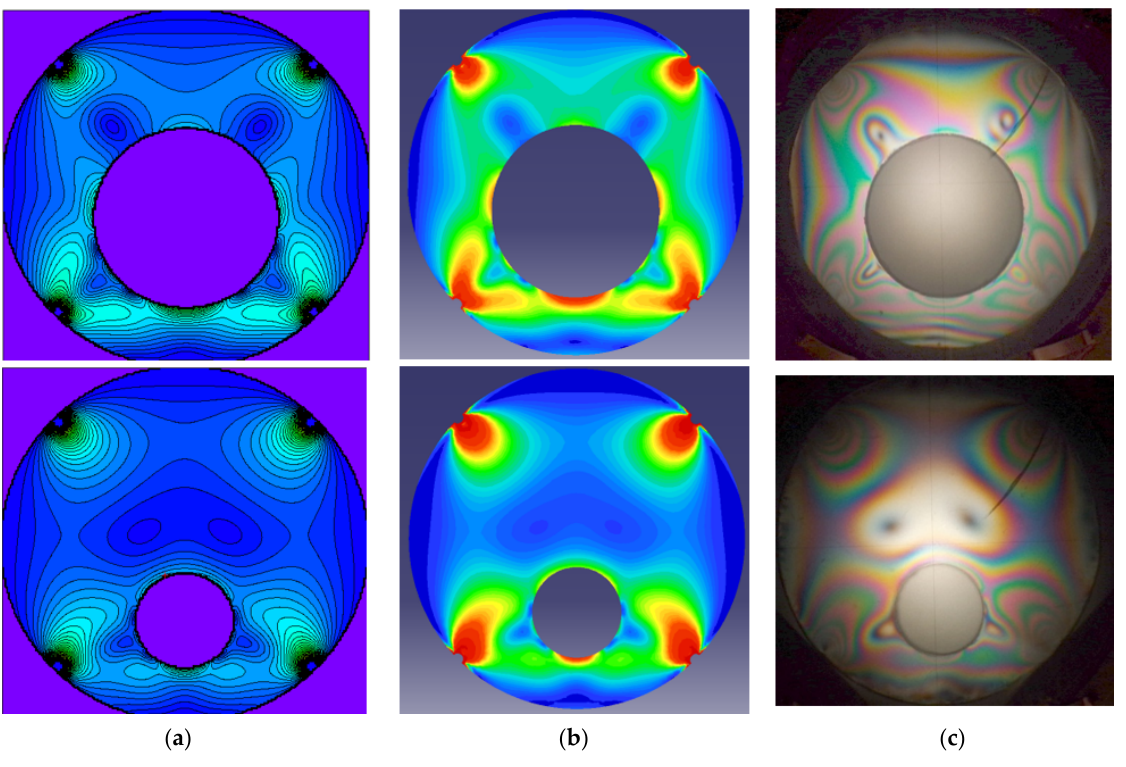
Figure 20. Isochromatic fields for two geometries of the ring compressed by four equidistant forces (loading Case f , Table 1): theoretical ( a ), numerical ( b ) and experimental ( c ) results.